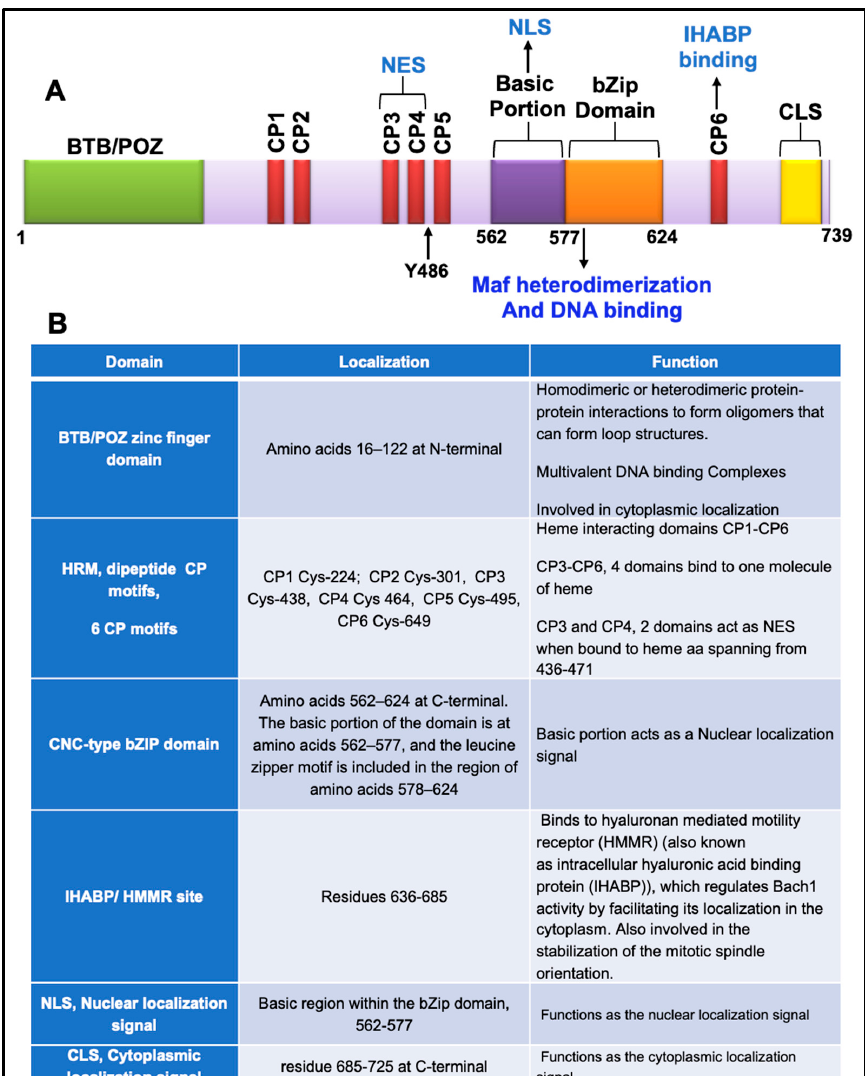
Figure 2. ( A ) Pictorial representation of mouse Bach1 protein structure with different domains. ( B ) Table illustrating the different functional domains present in the Bach1 protein.